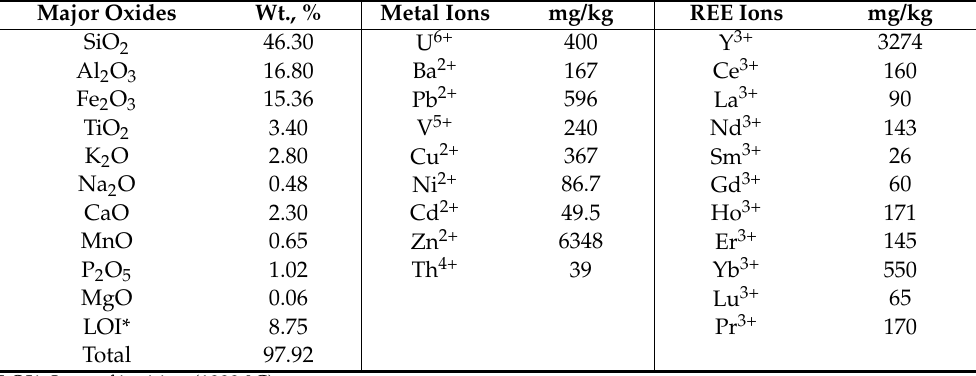
Table 5. Chemical analysis of lamprophyre dike ore.